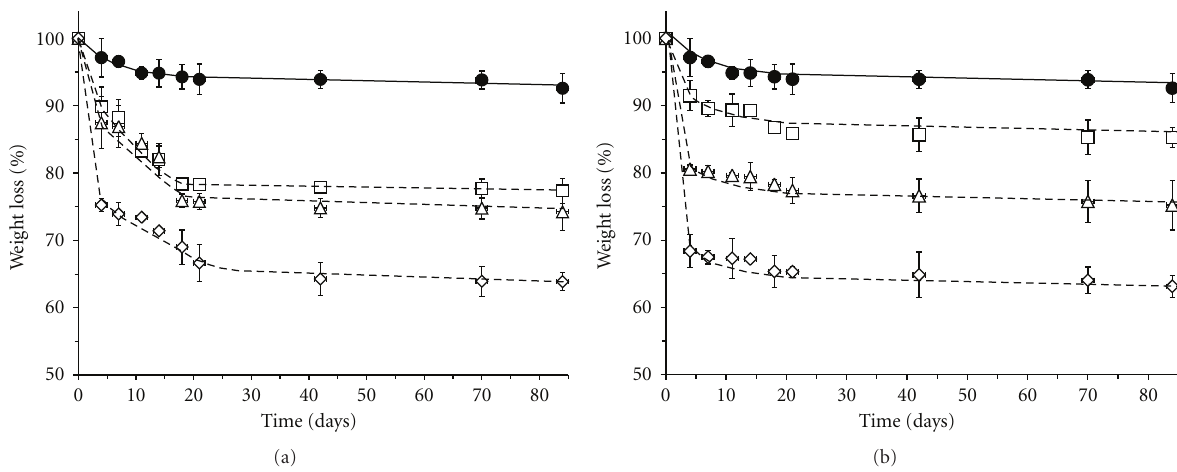
Figure 5: Change in weight loss profiles for PHB/PEG composite films with di ff erent PEG loadings (% w/w) when incubated under physiological conditions (37 ◦ C, pH 7.4, 120 rpm), (a) PEG106 and (b) PEG2000; ( • ) 0%—PHB, ( (cid:2) ) 10%, ( Δ ) 20%, and ( (cid:3) ) 30%.